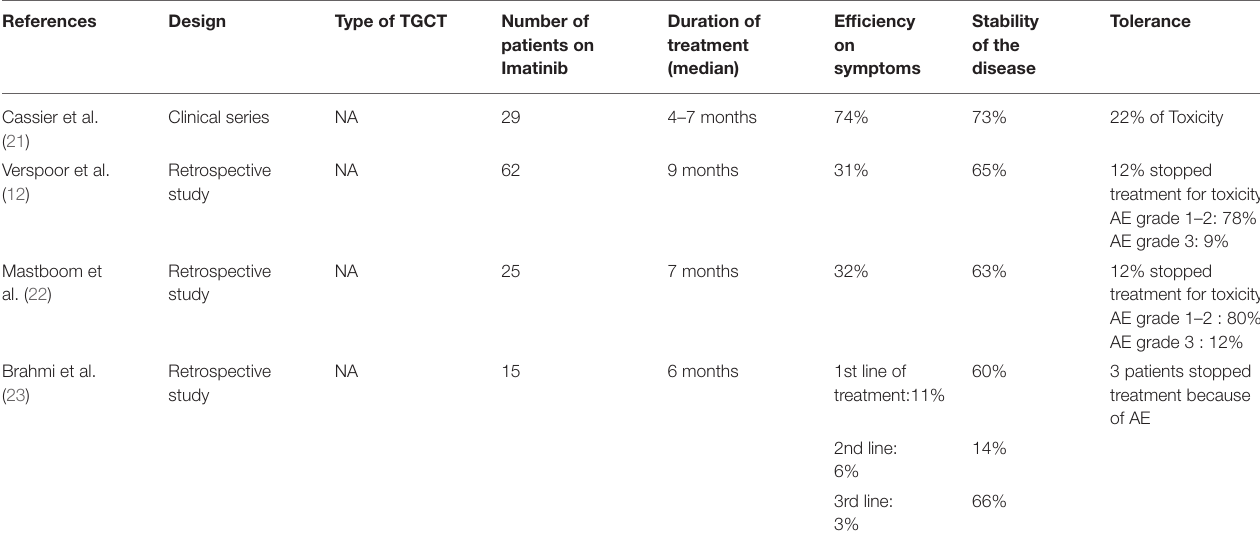
TABLE 2 | Clinical experiences with